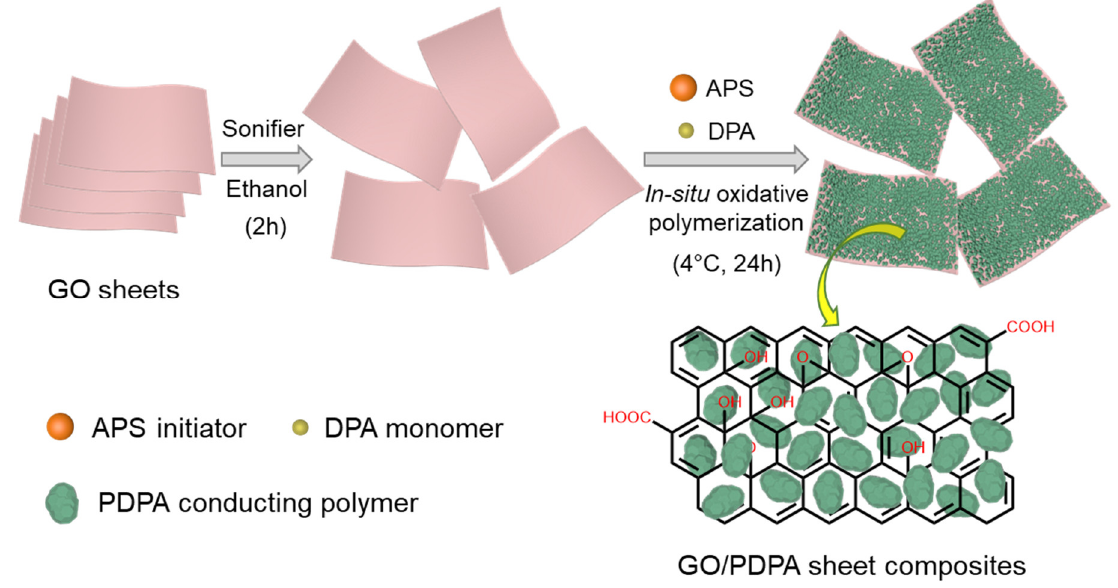
Scheme 1. Schematic diagram of the synthetic process of graphene oxide/polydiphenylamine (GO/PDPA) microsheet